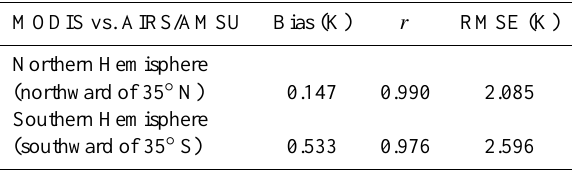
Table A1. Comparison of 9-day composite T skin (MODIS_ICE) and T skin (AIRS/AMSU). Bias: MODIS minus AIRS/AMSU, r : correlation coefficient, RMSE: root mean square error.